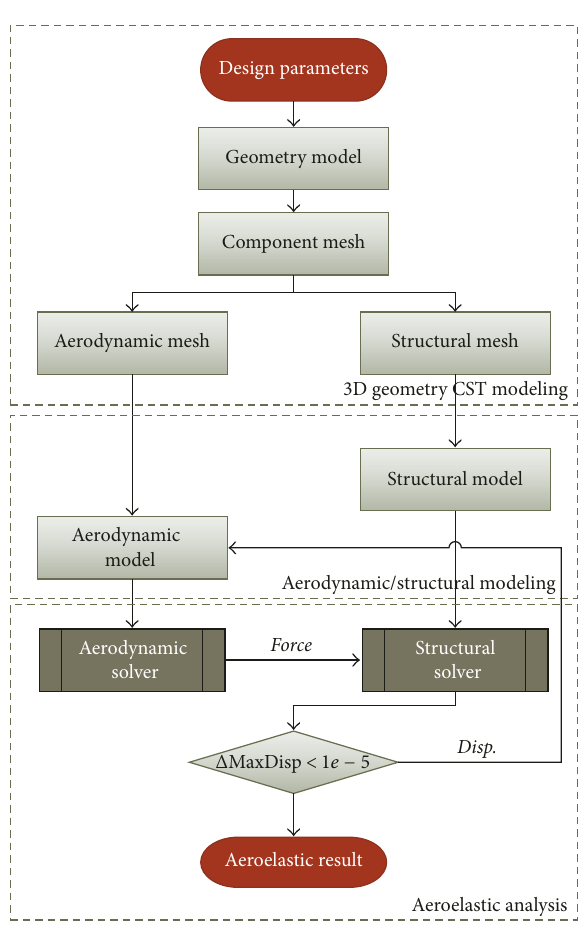
Figure 8: The process of aeroelastic modeling and analysis.